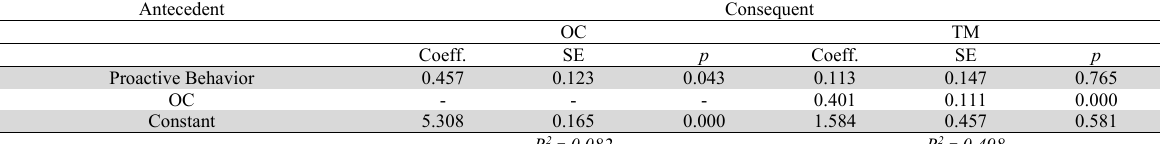
Multiple Regression (Mediation Analysis)